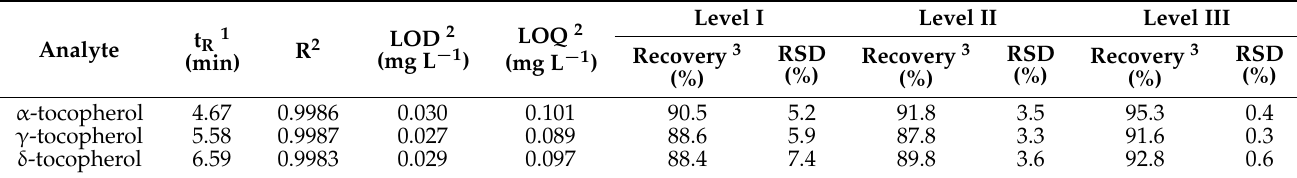
Table 1. Analytical characteristic of the method.